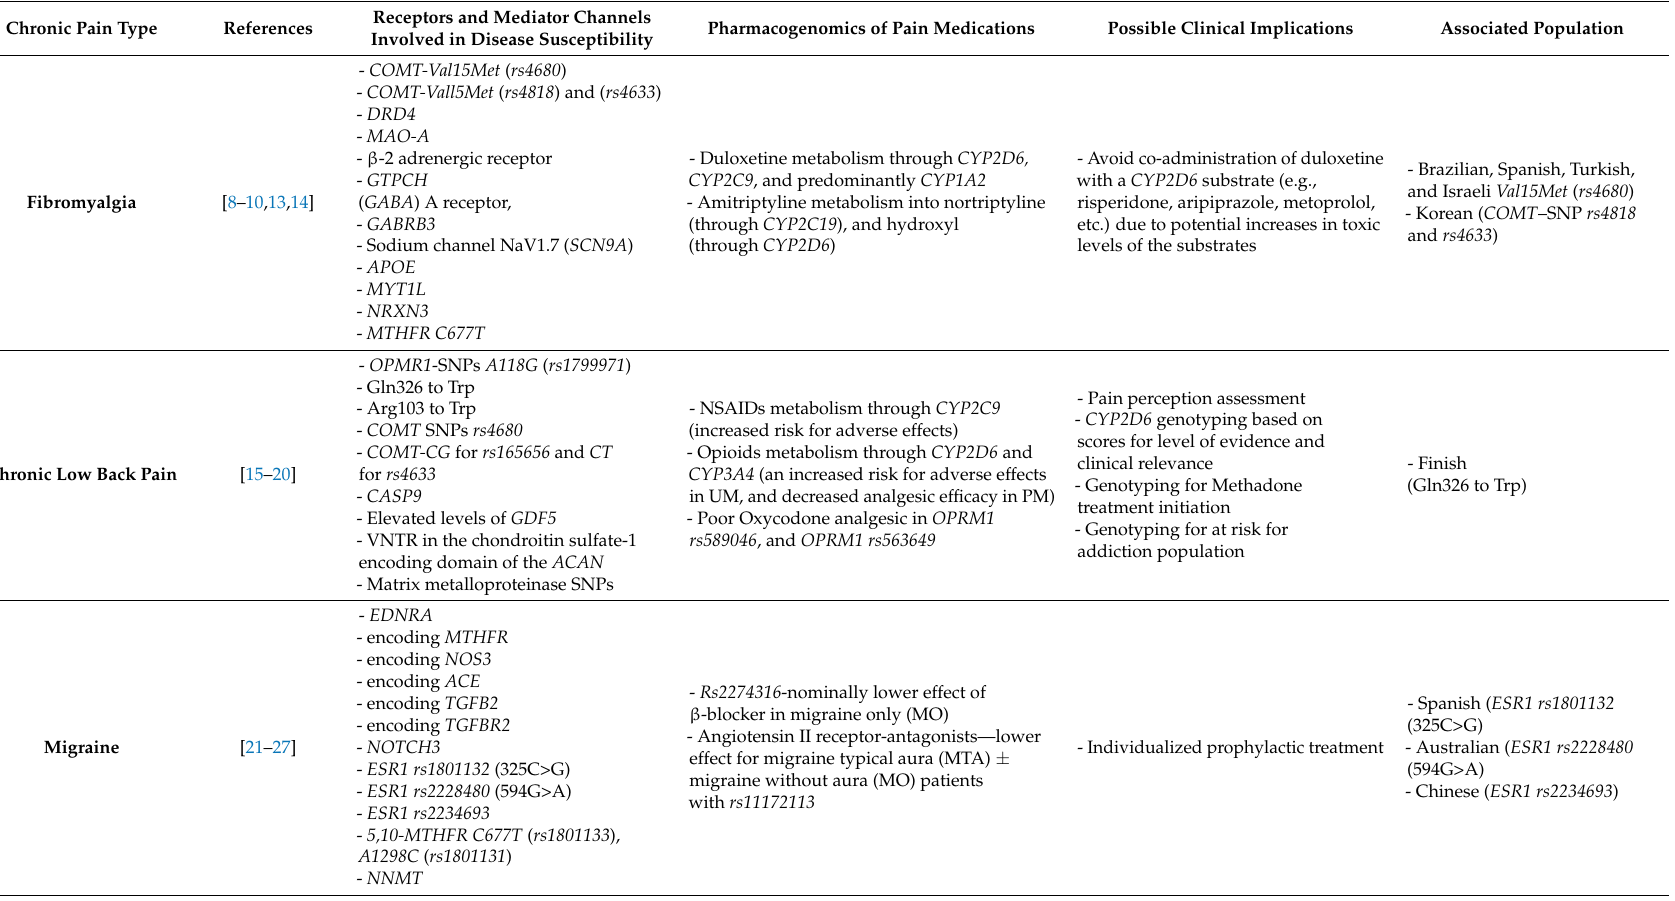
Table 1. Pharmacogenomics of disease processes and incidence of the main genetic polymorphisms in specific